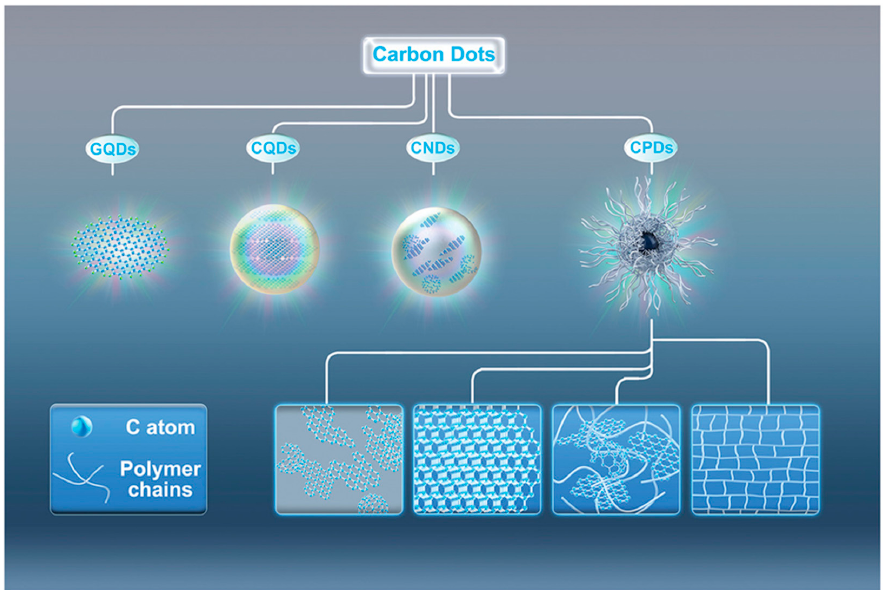
Figure 2. Classi fi cations of CQDs as reported by Hia et al. [41]. Picture reprint under Creative Figure 2. Classifications of CQDs as reported by Hia et al. [41]. Picture reprint under Creative Commons A tt ribution License 4.0 (CC BY). Commons Attribution License 4.0 (CC